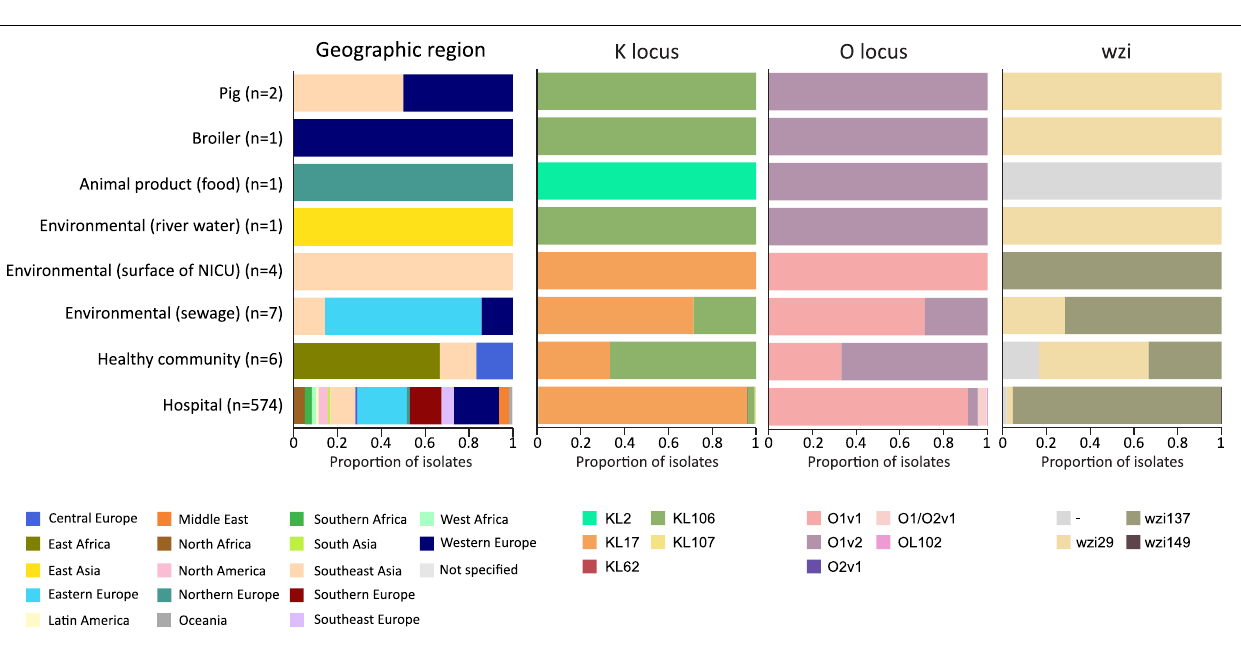
FIGURE 3 | Typing of hospital-associated, livestock-associated, healthy community and environmental K. pneumoniae